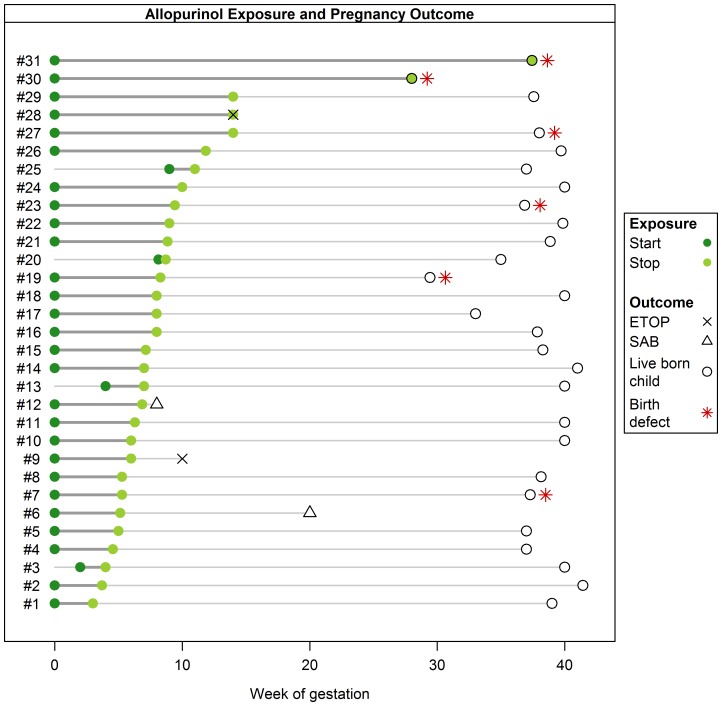
Diagram summarizing pregnancy interval of allopurinol exposure, week at first contact and outcome of 31 prospectively ascertained pregnancies.